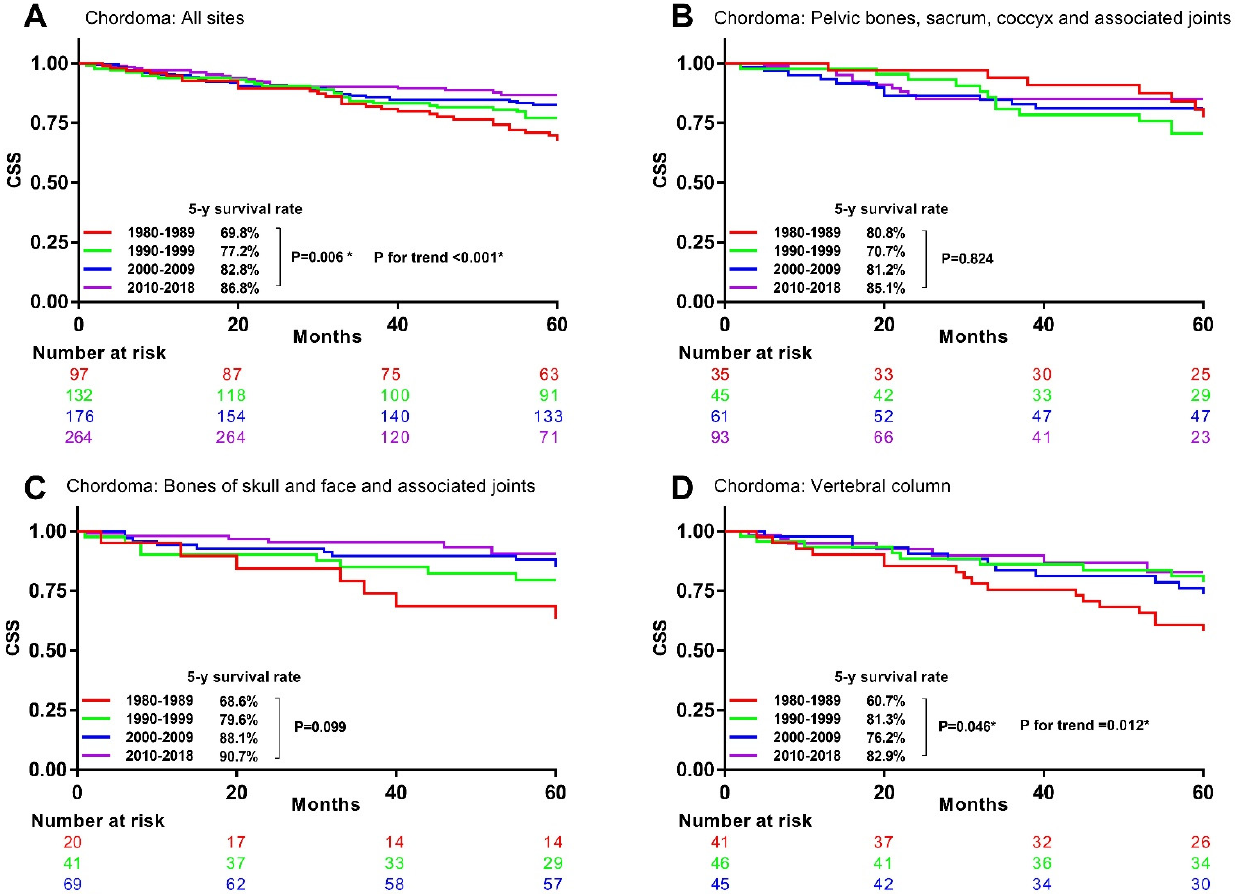
Figure 6. Kaplan–Meier curves showing 5-year CSS rates trend by decade in chordoma with different primary sites. CSS: bone sarcomas-specific survival. * Statistically significant. ( A ), All site ( B ), Pelvic bones, sacrum, coccyx and associated joints ( C ), Bones of skull and face and associated joints ( D ), Vertebral column.